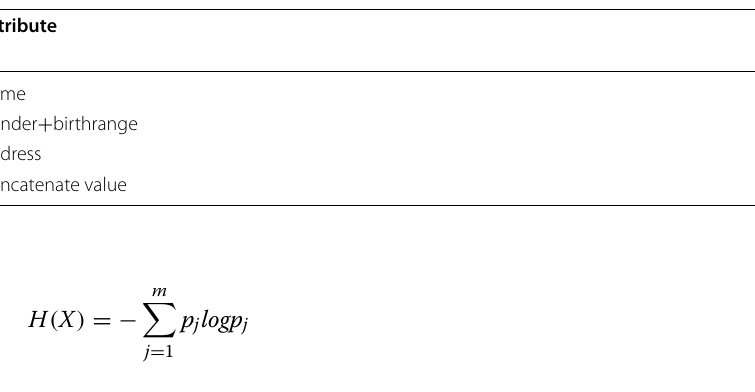
Table 6 Entropy of individual attributes and concatenated data